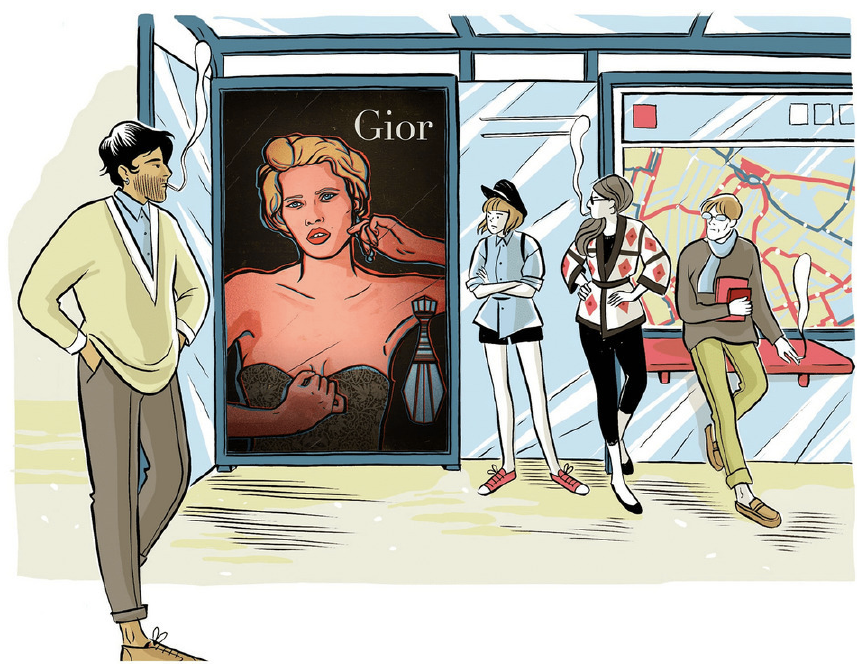
Figure 2: Protagonists and Drawing Style of the “Student World” Juxtaposed with the Fashion World